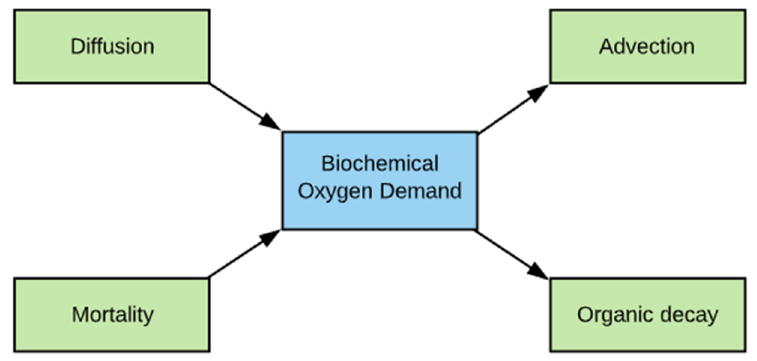
Figure 6. Schematic diagram of BOD cycle modeled by MINLAKE2020.